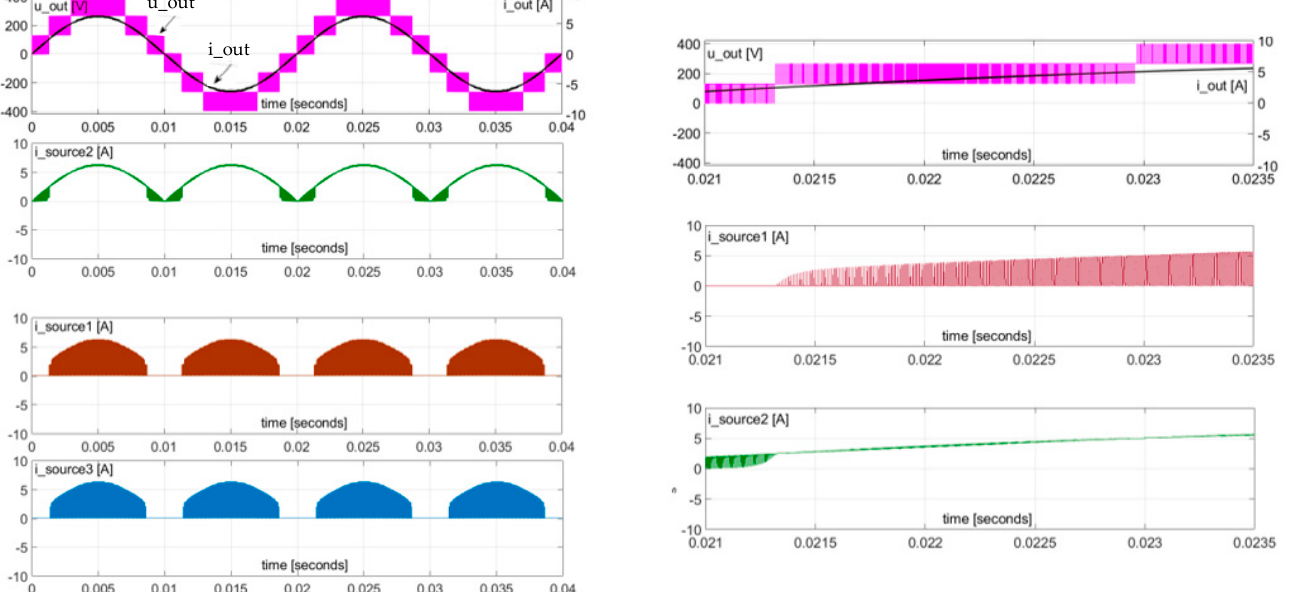
Figure 6. Waveforms in the seven-level inverter with three input voltage sources (Figure 5a) connected in parallel to C 1 , C 2, and C 3 ( U 1 = U 2 = U 3 = 133 V).